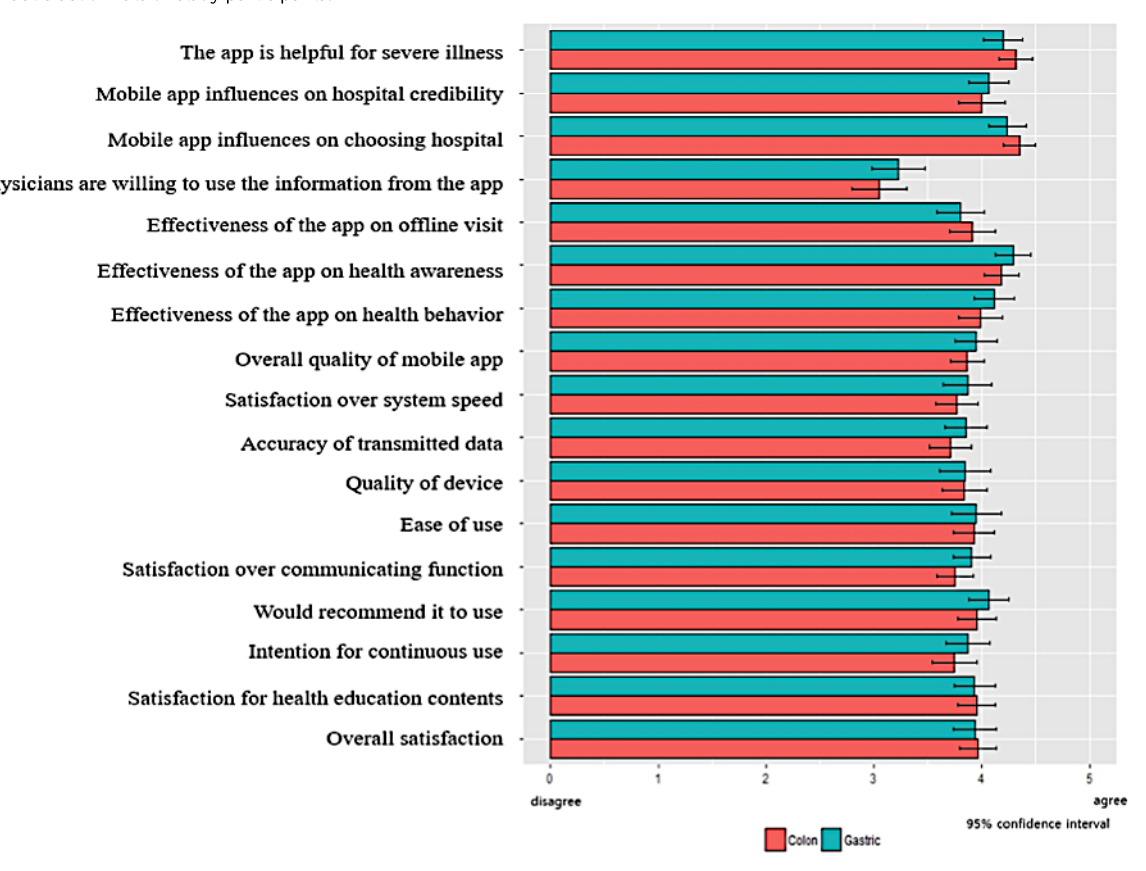
Figure 5. Satisfaction rate of study